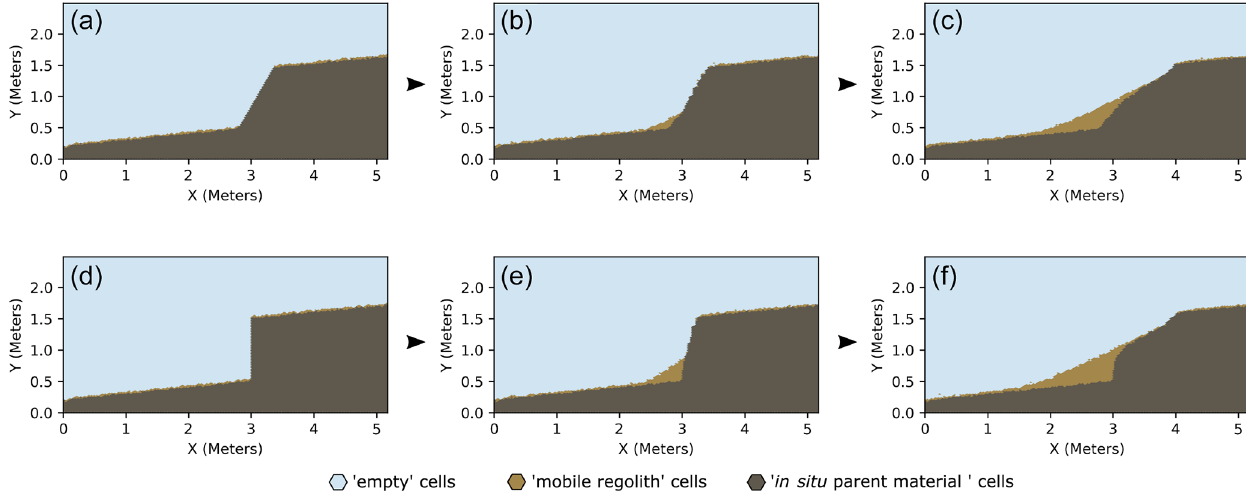
Figure 4. Example of the evolution of the colluvial wedge cellular automata models for a 60 ◦ dipping fault (a, b, c) and for a vertical fault (d, e, f) . In both models, there is an initial collapse whereby the fault face produces a layer of rapidly deposited mobile regolith cells that create a small wedge with a slope approximate to the angle of repose (30 ◦ ). The collapse phase is followed by a period of gradual deposition of mobile regolith cells that create an overall elongate